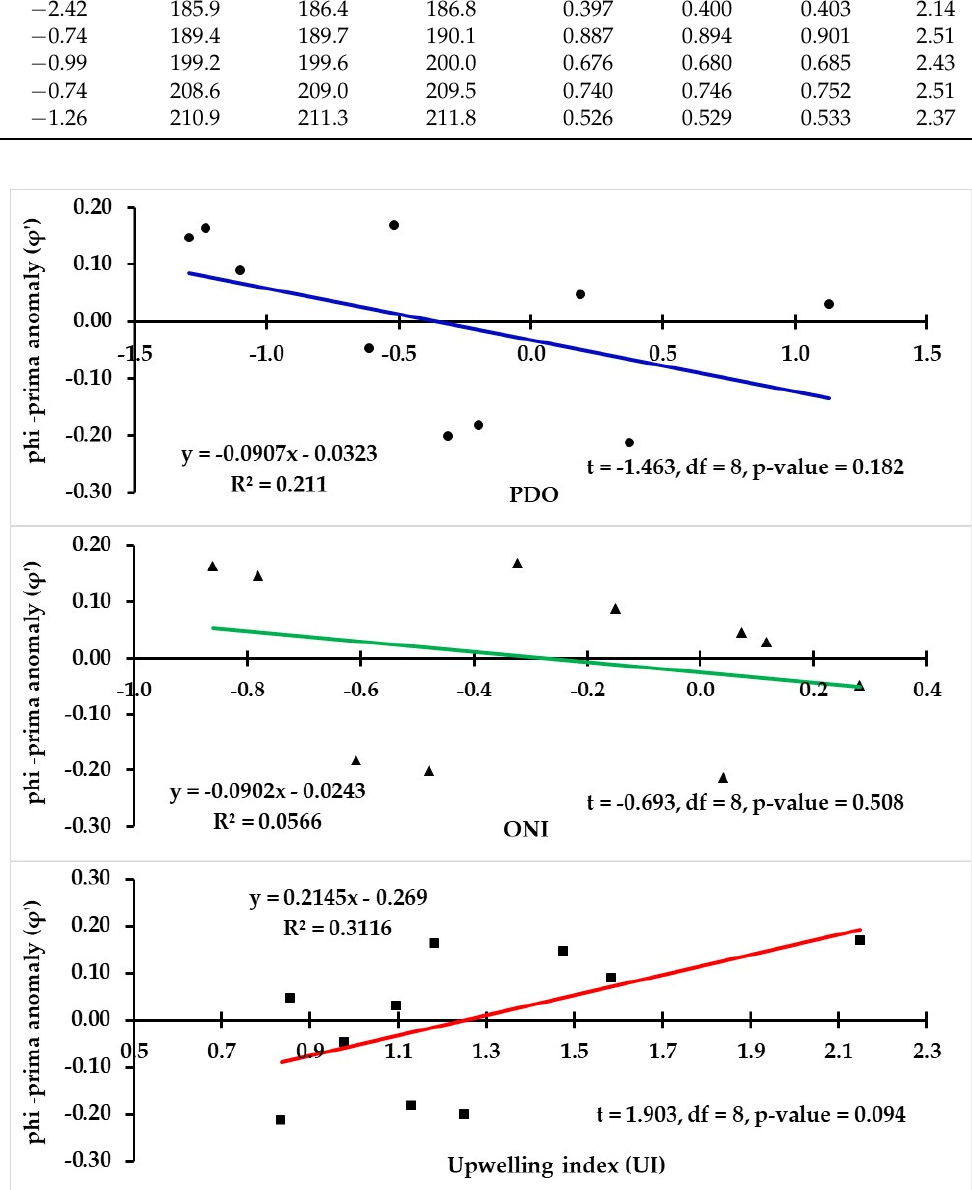
Figure 9. Relationship between the growth performance anomalies ( ϕ (cid:48) ) of the temperate Sardinops sagax stock and environmental indices (PDO, ONI, and UI).